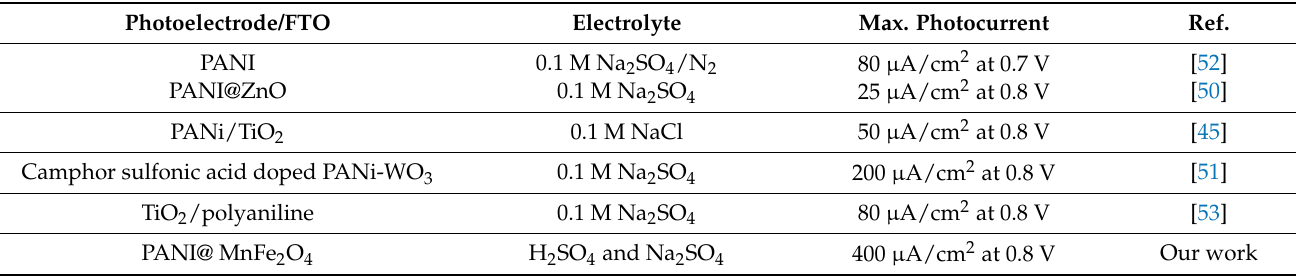
Figure 8. ( a ) IPCE and ( b ) ABPE of PANi A0, A-Fe1, A-Fe2 and A-Fe3. Table 2. Comparison of result with previous results .